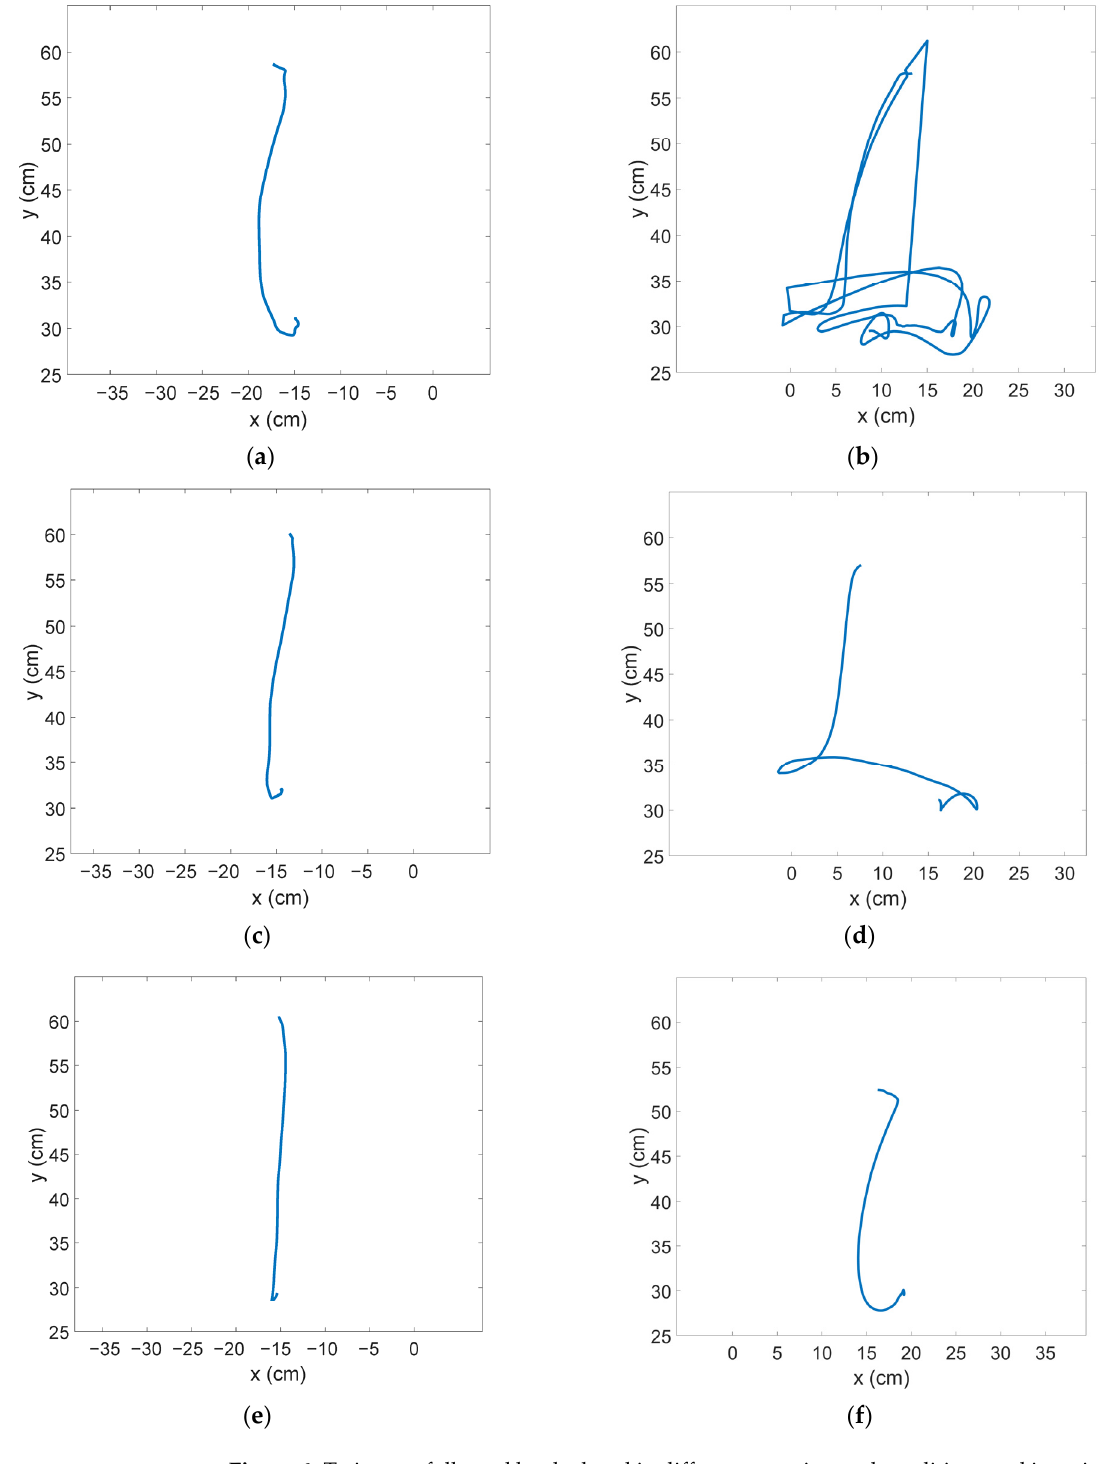
Figure 6. Trajectory followed by the hand in different experimental conditions and iterations in